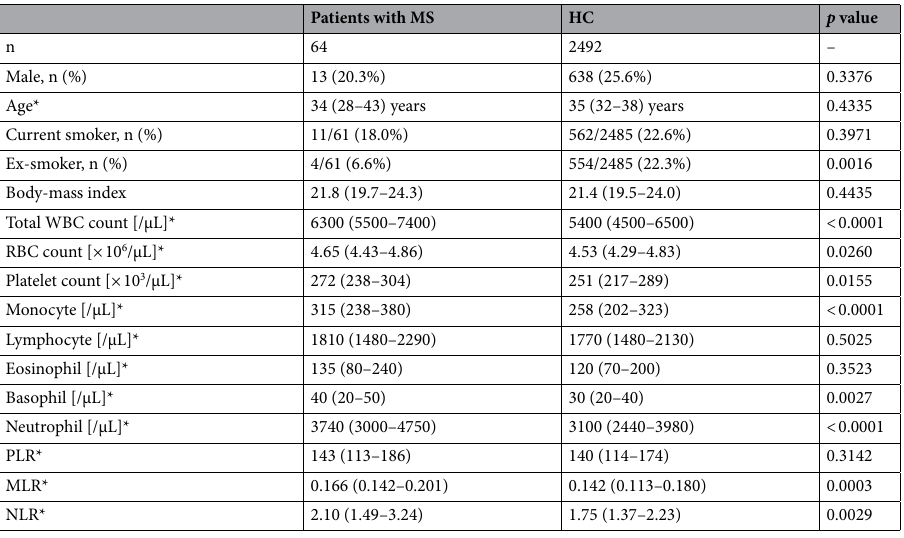
Table 1. Demographic and laboratory features of the patients with multiple sclerosis and healthy controls. The p values were calculated using the chi-square test for sex ratio and current smoker ratio, Fisher’s exact test for ex-smoker ratio, and the Mann–Whitney U test for other variables. The total WBC, monocyte, basophil, and neutrophil counts were significantly higher in the MS group than in the HC group. HC, healthy control; MLR, monocyte-to-lymphocyte ratio; MS, multiple sclerosis; NLR, neutrophil-to-lymphocyte ratio; PLR, platelet-to- lymphocyte ratio; RBC, red blood cell; WBC, white blood cell count. *Median and interquartile range (25–75